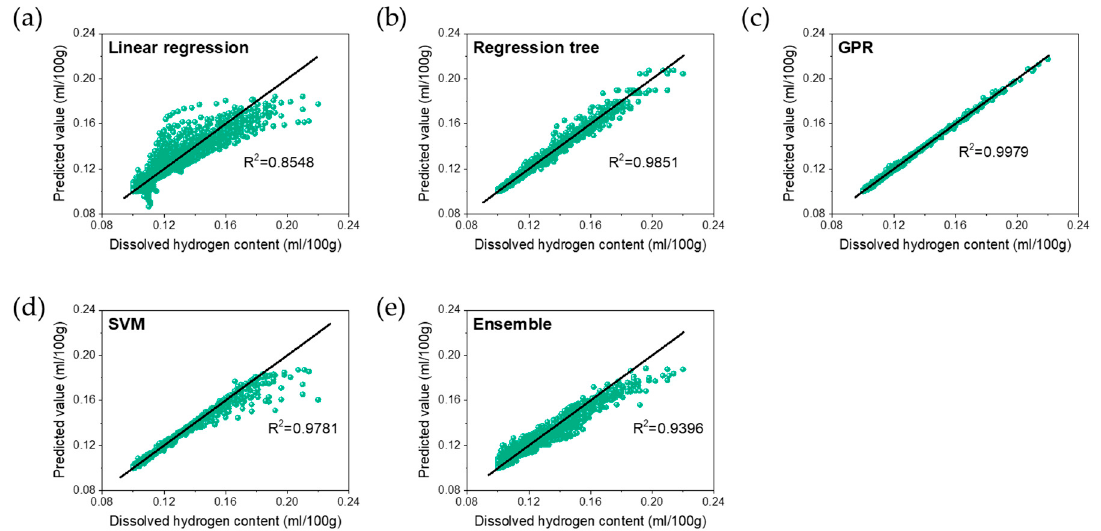
9 of 16 Figure 5. The comparison between measured values by experiment versus predicted values by linear regression model for temperature of liquid aluminum.